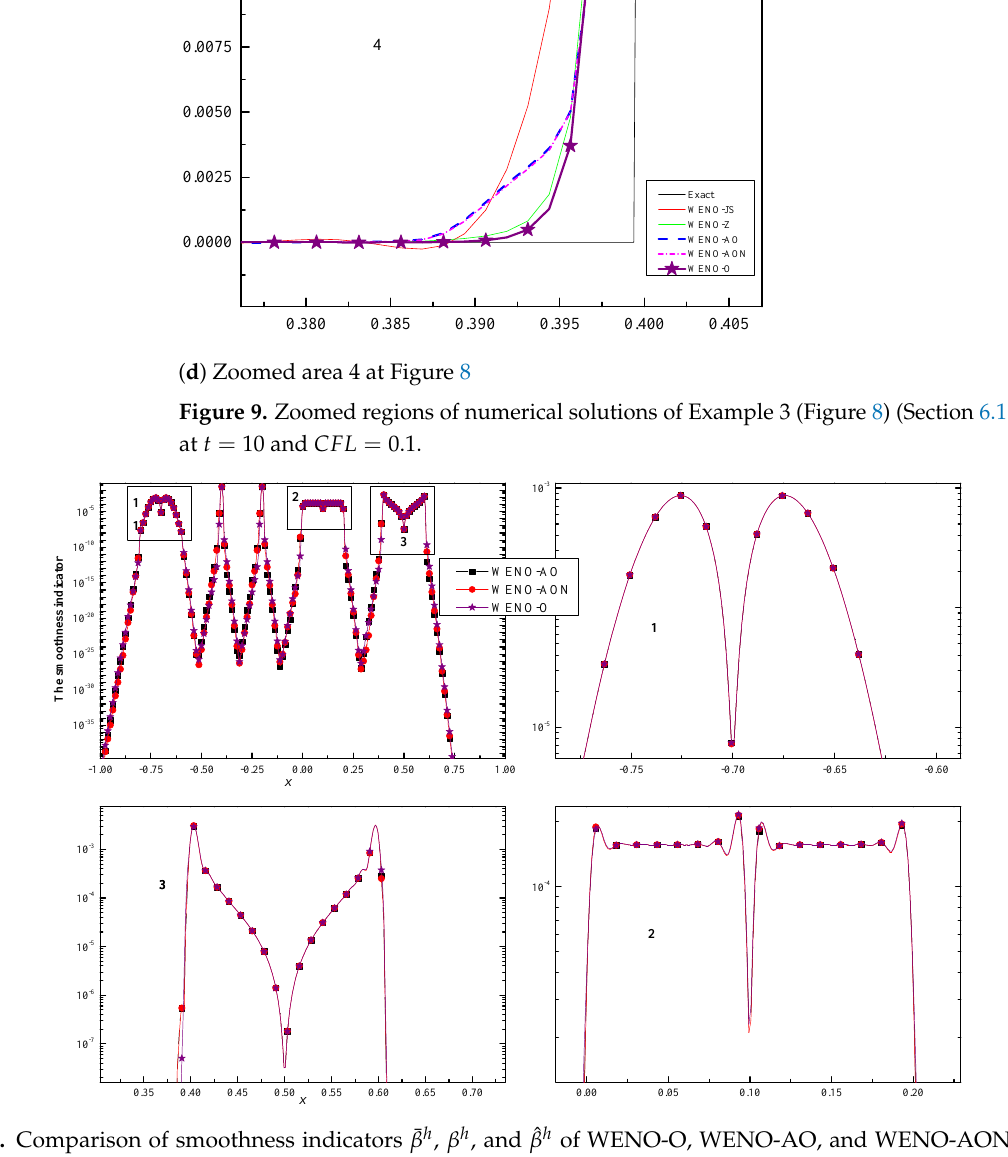
Figure 10. Comparison of smoothness indicators ¯ β h , β h , and ˆ β h of WENO-O, WENO-AO, and WENO-AON schemes, respectively, of Example 3 (Section